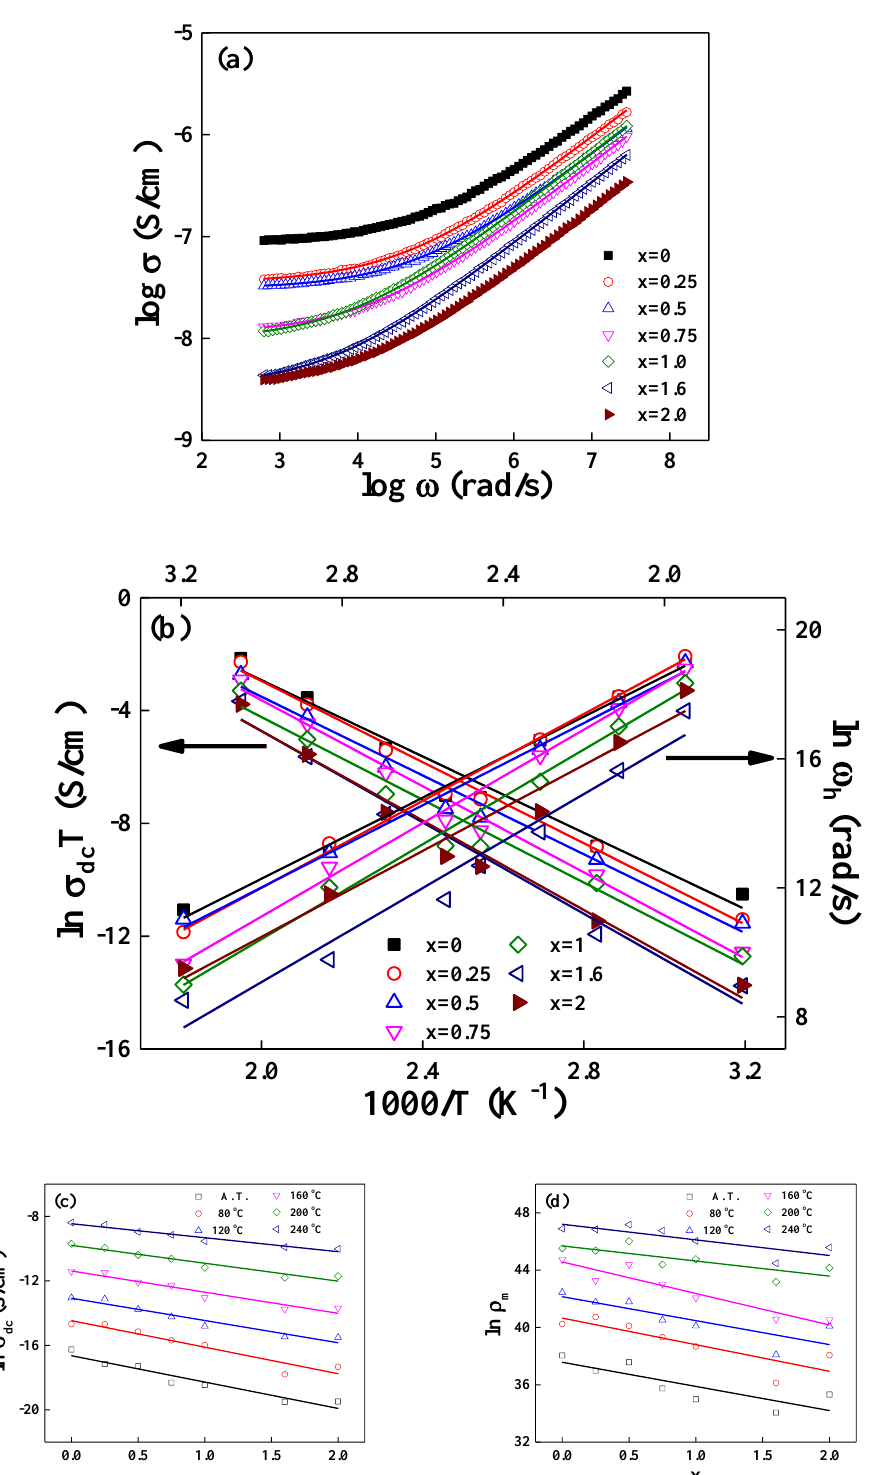
Figure 5. ( a ) Power–law frequency spectra of the real conductivity σ ( ω ) for 3Li 2 O-(2-x)Fe 2 O 3 - xMn 2 O 3 -3P 2 O 5 (x = 0, 0.25, 0.5, 0.75, 1.0, 1.6, 2.0) glasses, measured at ambient temperature. ( b ) Plots of ln σ dc T vs. 1000/T and ln ω h vs. 1000/T. The hopping frequency ω h , obeying the Arrhenius relation (cid:16) (cid:17) − E J ac ω h = ω 0 exp , is obtained from a fit to σ ( ω h ) = 2 σ dc . ( c ) Plot of ln σ dc vs. x at various k B T temperatures. ( d ) Plot of ln ρ m vs. x at various temperatures. The solid lines are the least squares straight line fits to the